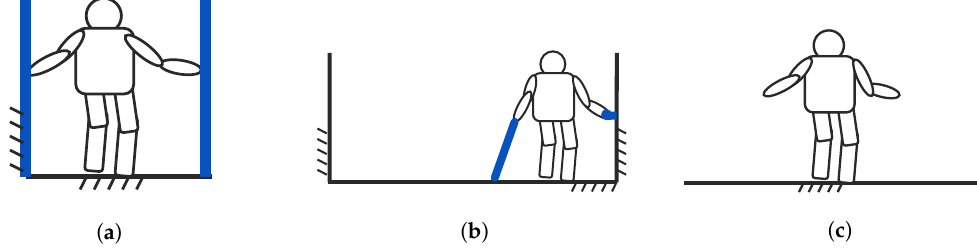
Figure 10. Difference of width according to environments in which support object is used. ( a ) Living space; ( b ) medical facility or nursing home; and, ( c )